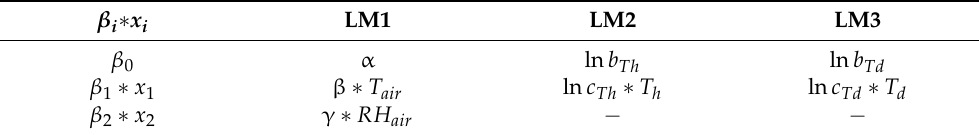
Table 4. Multiple linear regression models used for LM.